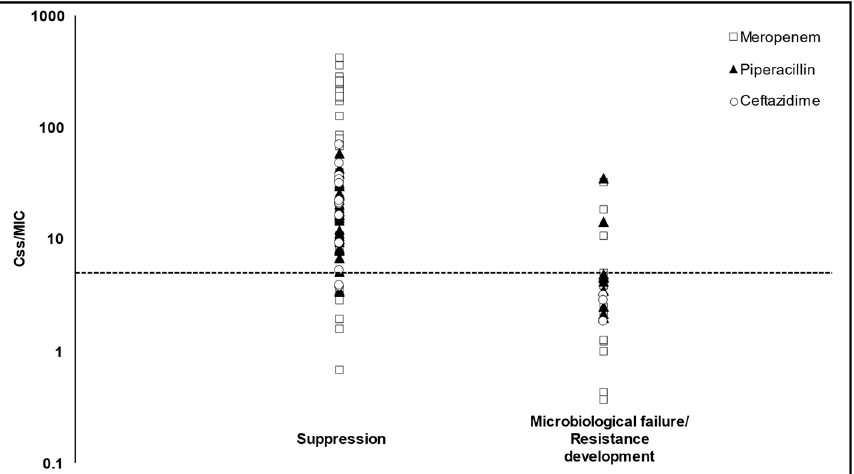
Figure 3. Relationship between beta-lactam PK/PD target attainment (C ss /MIC) and microbiological failure and/or resistance development. Each point represents a single critically ill patient treated with selected beta-lactams. Dotted line represents optimal PK/PD cut-off (C ss /MIC = 5) identified at ROC analysis. Significantly higher risk of microbiological failure and/or resistance occurrence was found in patients with a C ss /MIC below the optimal cut-off ( p < 0.001). C ss : steady-state concentrations.